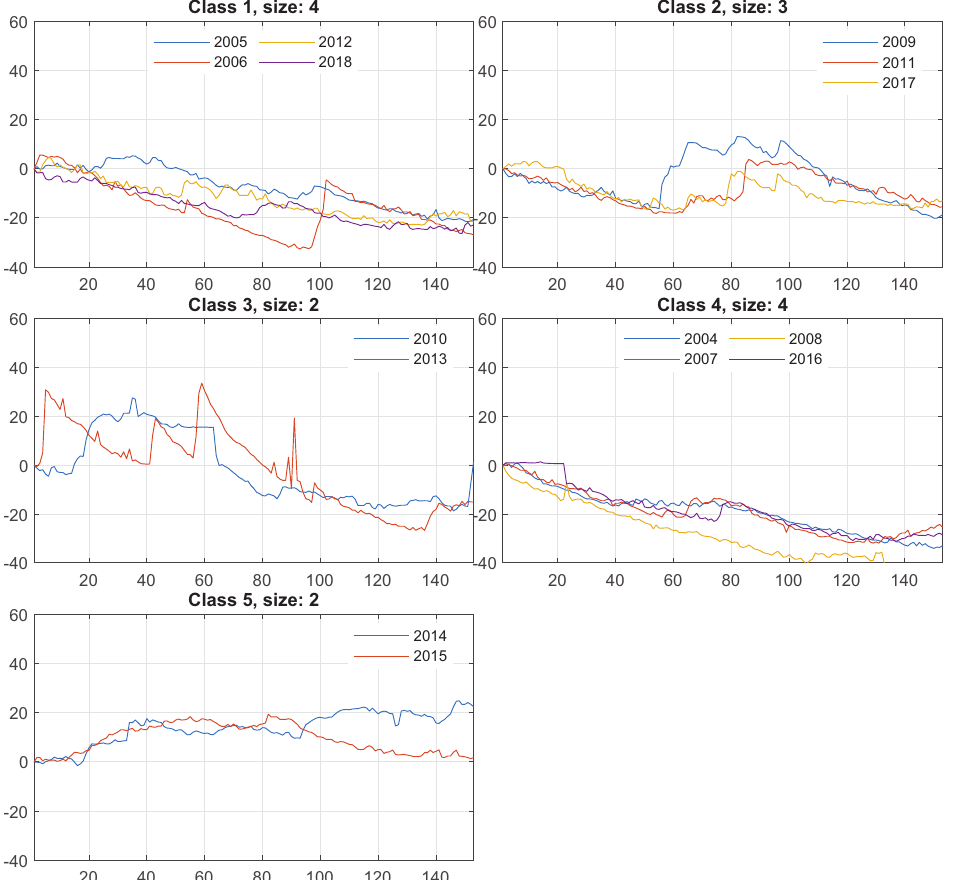
Figure 16. The clustering of the time series of detrended groundwater levels corresponding to the summer seasons by applying the AHP method. The years in legend are corresponding to the years in the dendrogram (Figure